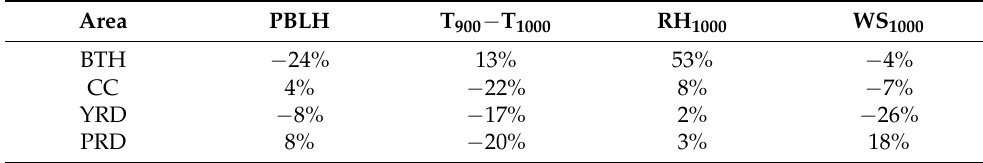
Table 5. The fractional changes of PBLH, T 900 − T 1000 , RH 1000 , and WS 1000 . Area PBLH T 900 − T 1000